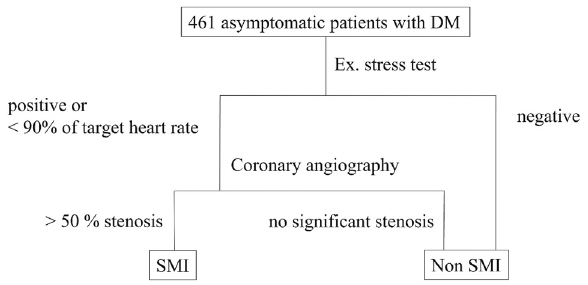
Figure 1. Study protocol. A total of 461 consecutive patients with diabetes mellitus were prospectively studied between July 2011 and August 2017. All patients were asymptomatic and self-sufficient in daily life and underwent the ERG test. Coronary angiography was performed if the stress test was positive, or if the patients did not achieve 90% of the target heart rate. Non-SMI was diagnosed without coronary angiography if the ERG was negative. Thirty-eight patients underwent coronary angiography despite a negative exercise test. None of the patients had a significant coronary lesion. ERG ergometer exercise, SMI silent myocardial